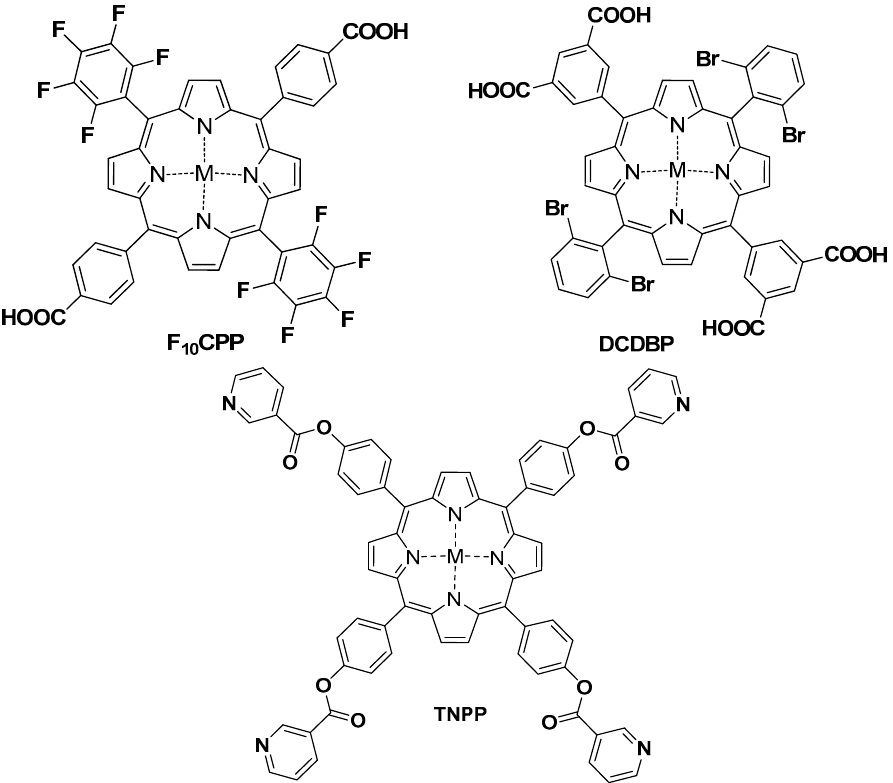
Figure 1. Porphyrins used in the preparation of Por-MOFs reported as catalysts in oxidation reactions. Table 1. Por-MOFs reported as catalysts in oxidation reactions.